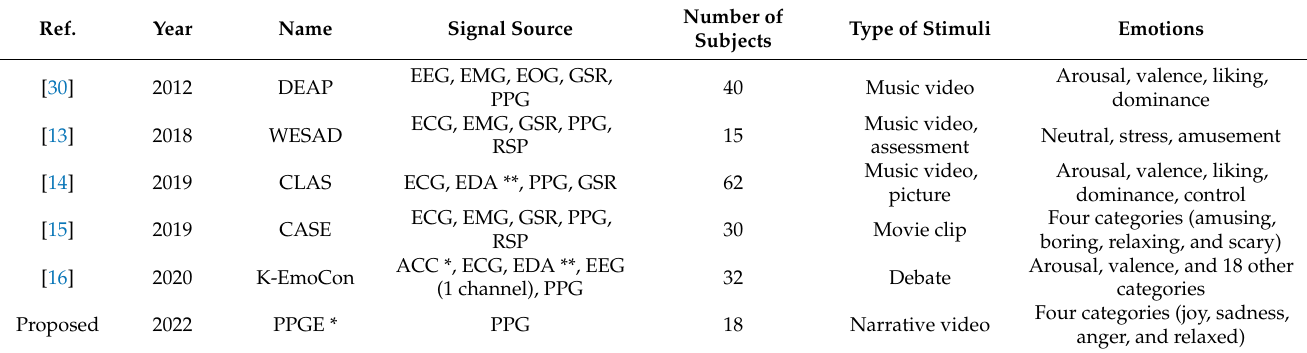
Table 13. Physiological signal dataset with PPG for emotional